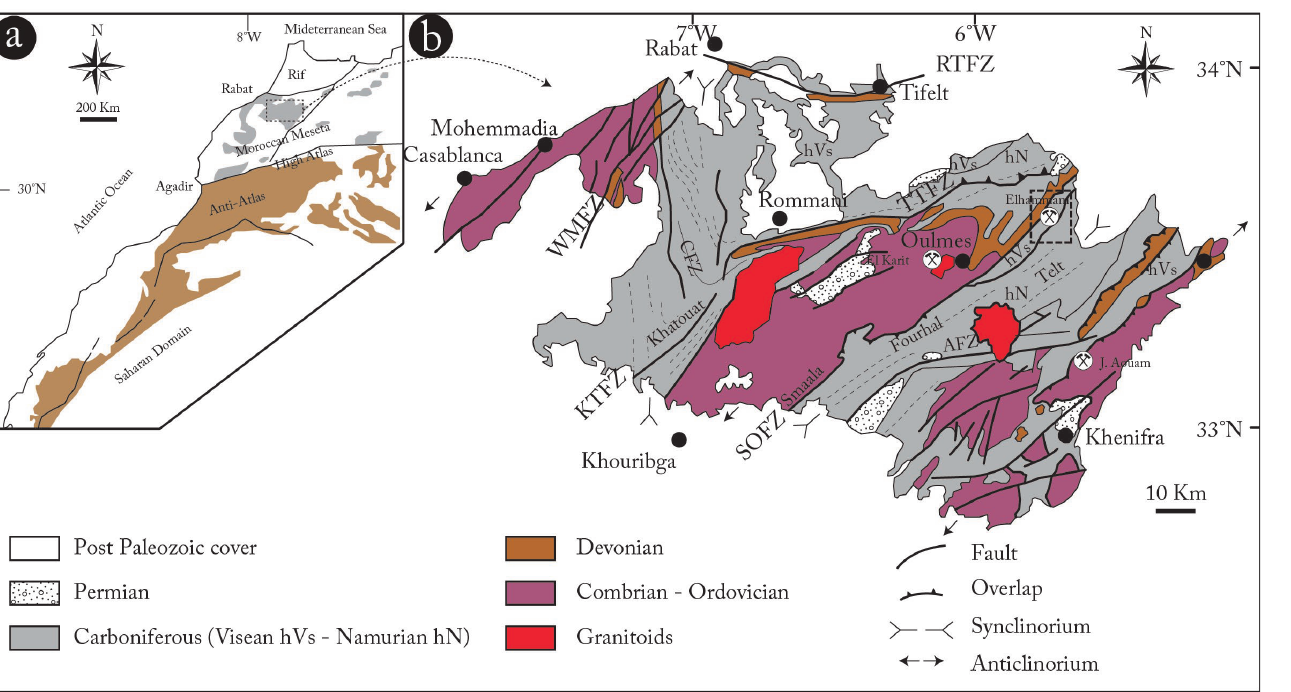
Figure 1. Map of the structural domains of Morocco and location of the Central Morocco domain ( a ) and main structural units [1,2] ( b ). (WMSZ: West Mestian Shear Zone, RTFZ: Rabat-Tifelt Fault Zone, SOFZ: Smaala-Oulmes Fault Zone, TTFZ: Tsili-Tfoudeit Fault Zone, AFZ: Aguelmous Fault Zone, KTFZ: Kef Tallal Fault Zone, CFZ: Cherrat Fault Zone).